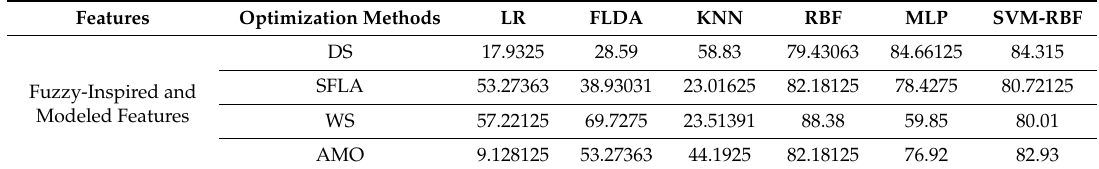
Table 12. Average Performance Index (%) among the classifiers at various optimization techniques with di ff erent features for normal cases.